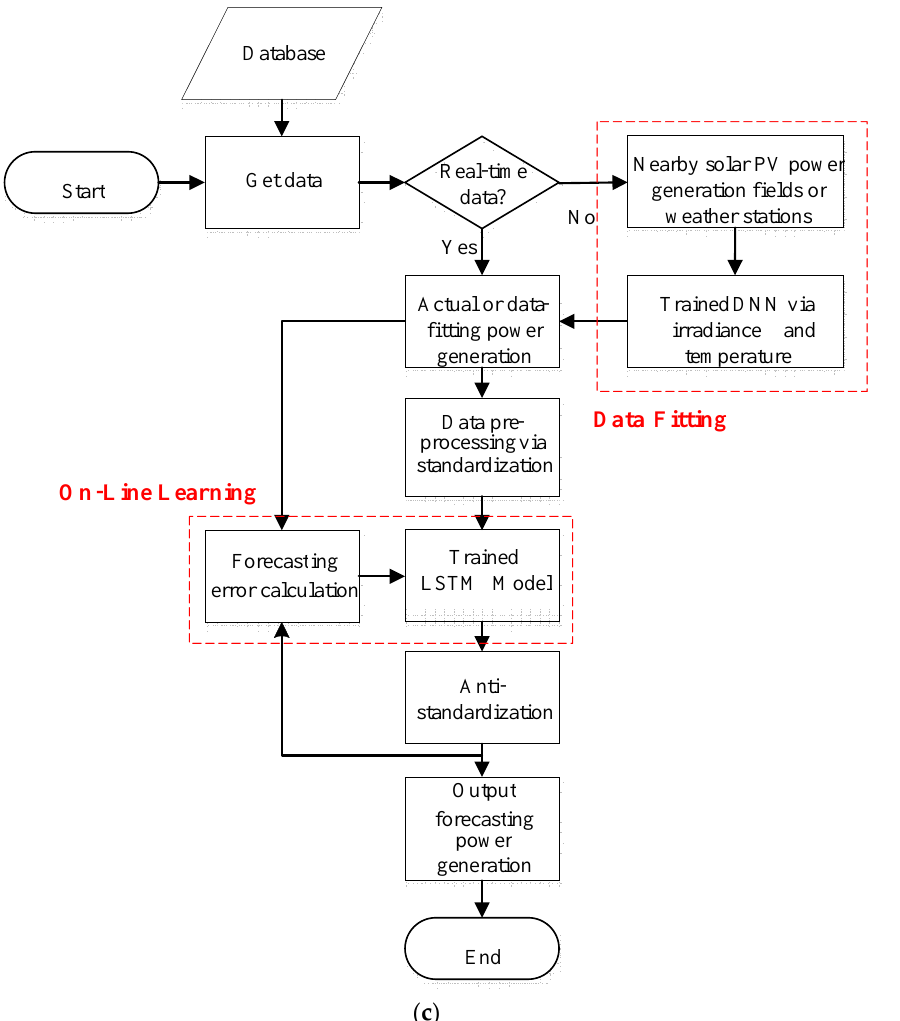
Figure 4. Solar PV power generation forecasting strategy: ( a ) training process of LSTM; ( b ) training process of the DNN data fitting; ( c ) implementation procedure of proposed DNN-LSTM model.